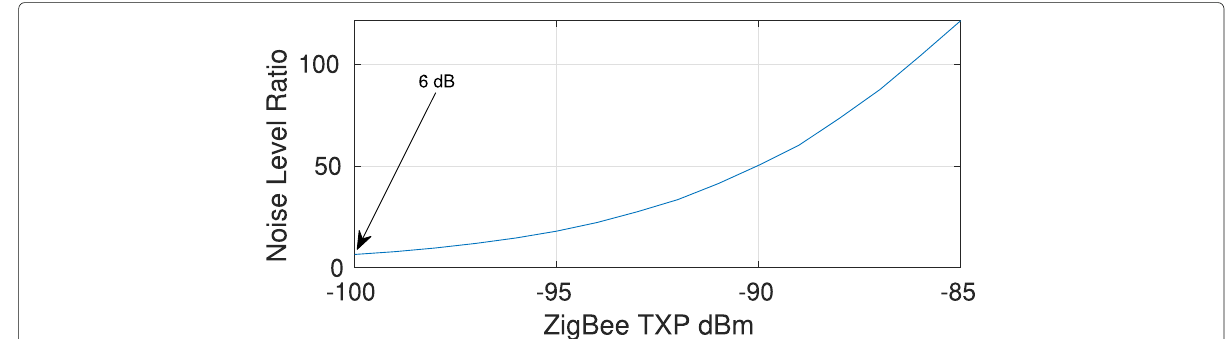
Fig. 14 Interference detection: a noise level ratio of 6 dB is observed for an interference TXP as low as - 100 dBm